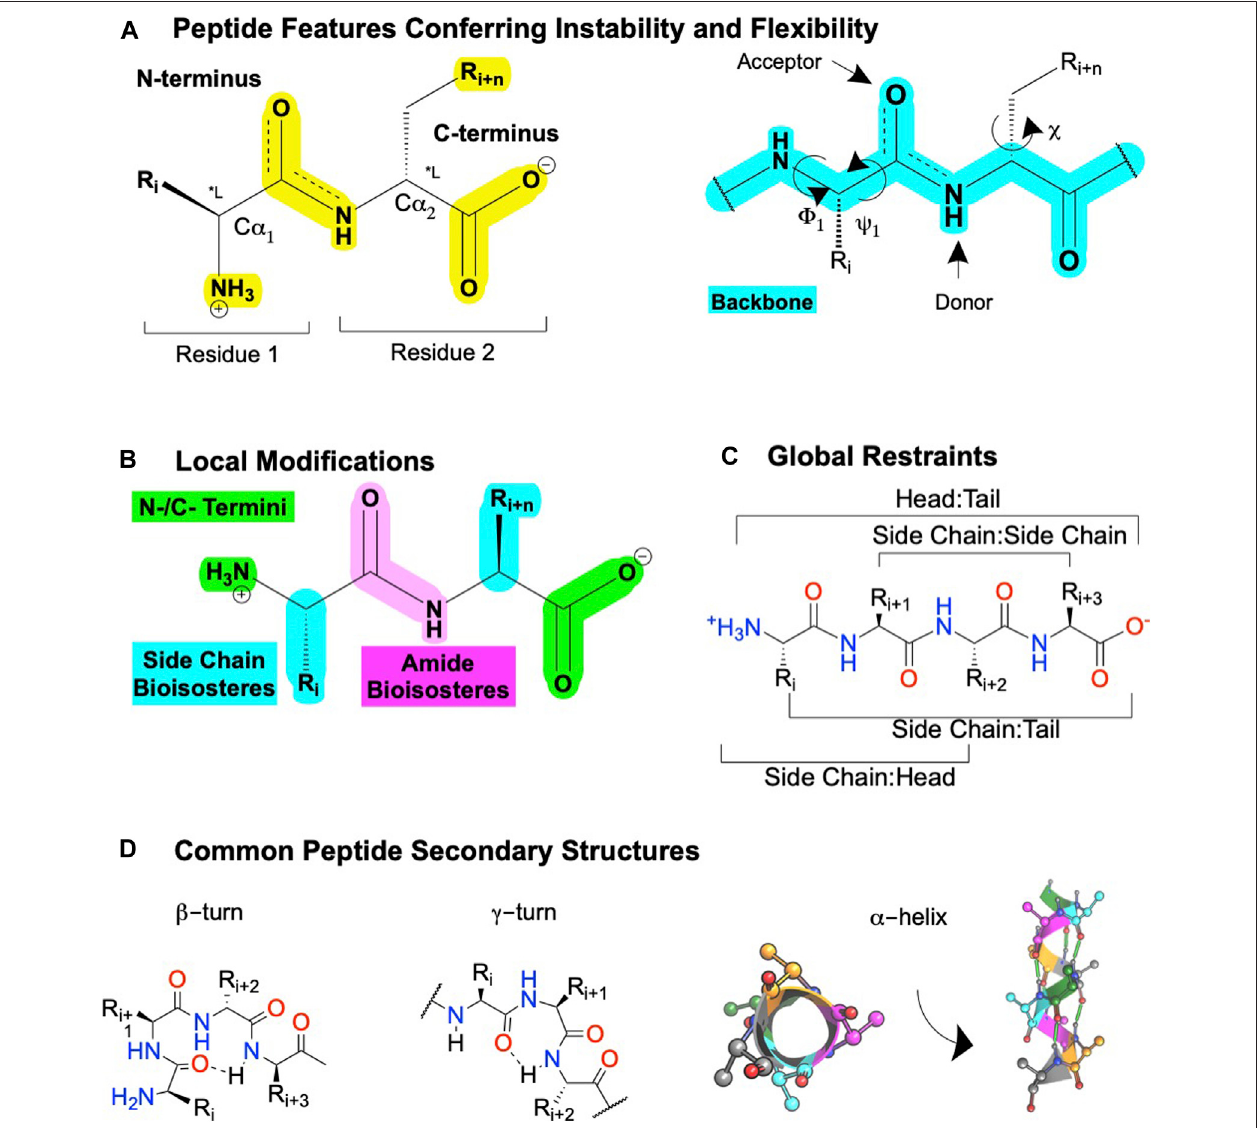
FIGURE 5 | Peptide features and peptidomimetic modi fi cations to improve their drug-like properties. (A) Peptide nomenclature dictates sequences are written left torightstartingwiththeN-terminallabeledas"residue1 ′ ,witheachresidueconnectedbyanamidebond,i+n (left) .Sitesforlocalmodi fi cationsarehighlightedinyellow (right) , with the peptide backbone highlighted in cyan. The peptide nomenclature and types of peptidomimetic modi fi cations to improve drug-like properties of linear peptidesinclude (B) localsubstitutions ofsidechains(cyan), modi fi cationsoftheC- andN- termini(green),and amidebioisosteres (pink). (C) Global modi fi cations. (D) Commonsecondarystructuresforpeptidesincludingat β -turn,a γ -turn,and (left) a α -helixtop-downviewor (right) α -helixsideview.Dottedlinesorgreencylinders show backbone H-bonds. Figure was created with BioRender.com, 1 Chemdraw20.0, MarvinSketch, 5 and Molecular Operating Environment (MOE).